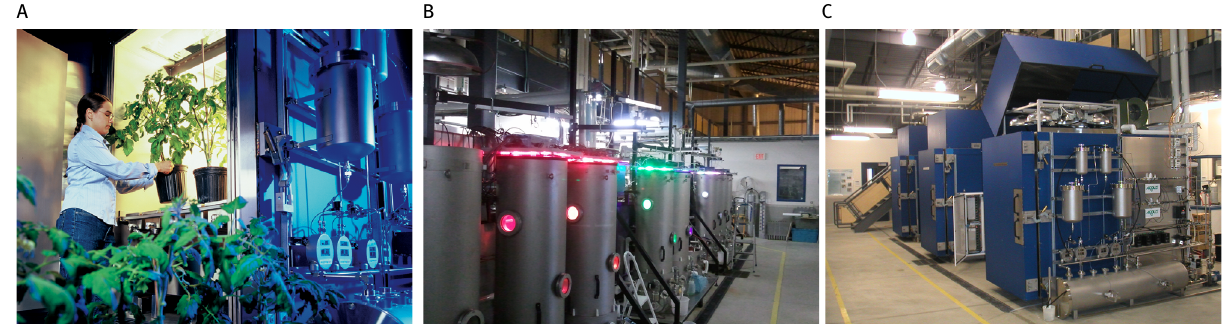
Figure 3: Hypobaric Plant production facilities at the University of Guelph’s Controlled Environment Systems Research Facility. A) Evaluation of tomato and pepper growth and development under sub-atmospheric pressure. B) Smaller scale hypobaric chambers outfitted with multi- spectral (9 tunable wavebands) high output (10,000 µmol/m 2 /s @ full spectrum and full intensity) LED arrays. C) Suite of five (three shown) 1.5 m 2 full canopy hypobaric plant production chambers (note: lighting is high pressure